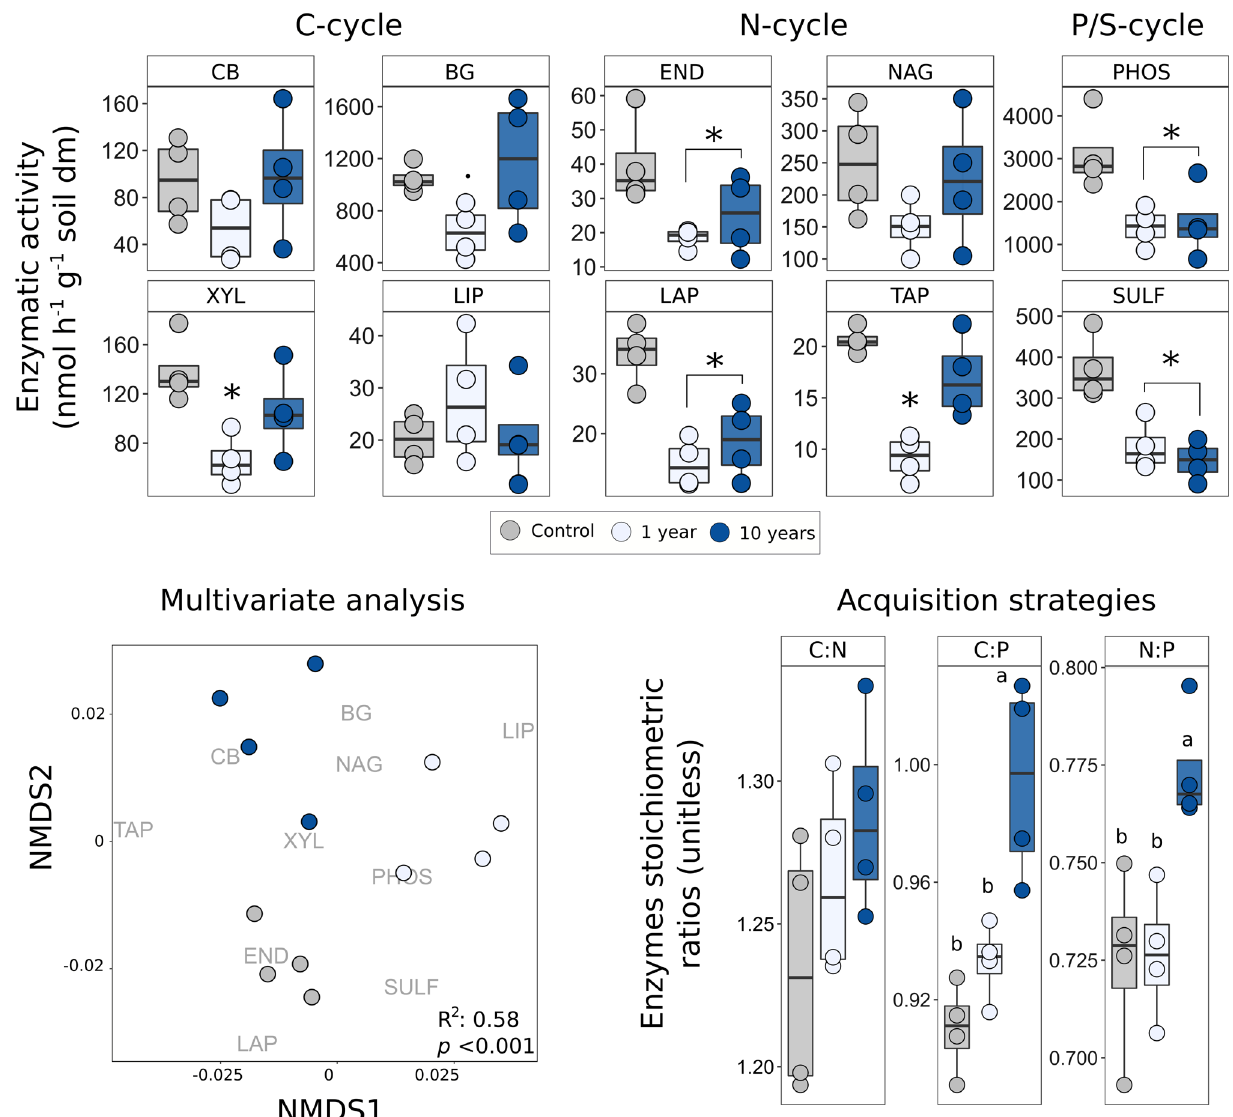
Fig. 3 Effects of drought on the potential enzymatic activity in soil. Colour indicates soil treatment (control = grey, 1 year = light blue, 10 years = blue). Top graphs show the potential enzymatic activities of all measured enzymes, grouped for C-, N-, and P- and S-cycle-related enzymes (for full description of enzymes see Supplementary Table 1). C-cycle enzymes all show a similar trend, where 10 years have similar values to the control, and the 1 year is always different (only statistically signi fi cant in XYL: F -value = 6.68, p = 0.016, n = 4; and partially signi fi cant in BG: F -value = 3.2, p = 0.089, n = 4). N-cycle enzymes show different responses of the 10-year treatment, where, in two enzymes both drought treatments show a decrease (END: F -value = 4.9, p = 0.036, n = 4; LAP: F -value = 14.58, p = 0.0015, n = 4), and in the other two only the 1-year treatment shows decreased values, while 10 years show values similar to control (only signi fi cant in TAP: F -value = 18.79, p < 0.001, n = 4). P- and S-cycle enzymes show the same trend where both drought plots are signi fi cantly different from the control (PHOS: F -value = 6.53, p = 0.018, n = 4; SULF: F -value = 14.75, p = 0.0014, n = 4). Stars represent signi fi cant differences with the Tukey HSD post hoc test while a dot represents partially signi fi cant values ( p < 0.1). Bottom left panel shows the NMDS of potential enzymatic activities for the year 2017, with a clear separation between all treatments ( R 2 = 0.58, p = 0.0003, n = 4, stress = 0.13). The bottom right panel represents acquisition strategies (stoichiometric ratios of the potential enzymatic activities), where a similar trend was found for all the ratios, although only statistically signi fi cant in C:P and N:P (respectively, F -value = 14.8, p = 0.001, n = 4; F -value = 8.6, p = 0.008, n = 4). Letters represent results from two-sided Tukey HSD post hoc test. Box centre line represents median, box limits the upper and lower quartiles, whiskers the 1.5x interquartile range, while separated points represent outliers. The sample size ‘ n ’ represents biologically independent